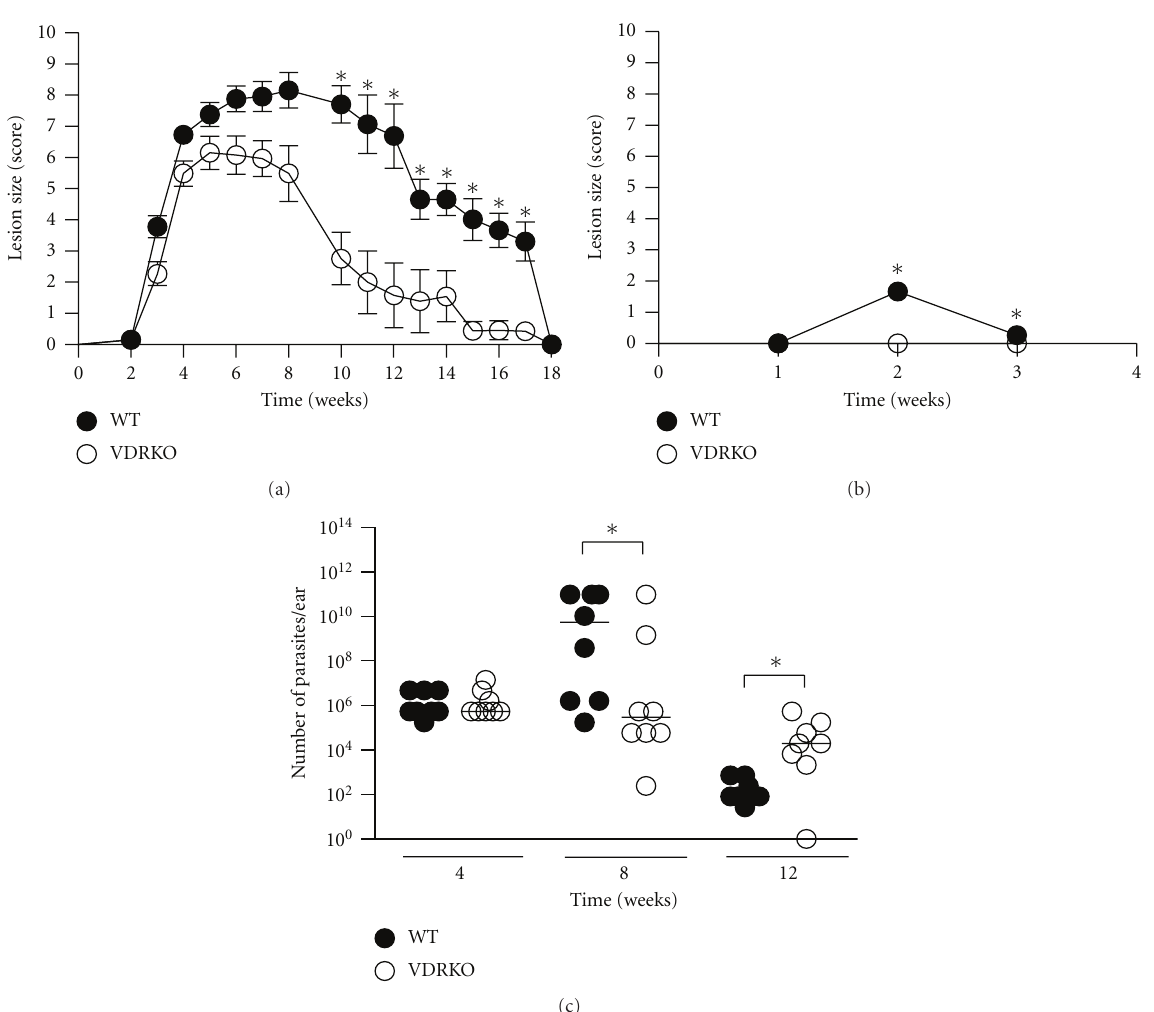
Figure 1: VDRKO mice develop smaller lesions when infected with L. major . C57BL/6 WT (closed circles) and VDRKO (open circles) mice were infected in the ear with 10 5 L. major parasites. (a) Cumulative measurement of lesion size (score) was measured over the course of infection. One representative of 5 independent experiments is presented; ∗ P ≤ 0 . 05. (b) Mice were reinfected upon complete resolution of the primary infection (wk 18) and lesions were measured until completely healed. Mean lesion score ± SE is presented; n = (11–21 ears). One representative of 2 independent experiments is presented. (c) Parasite burden of infected ears from VDRKO and WT mice was determined at 4, 8, and 12 weeks after infection by performing a limiting dilution assay. Each point indicates the parasite load in a single ear. One representative of 2 independent experiments is presented. ∗ P ≤ 0 .